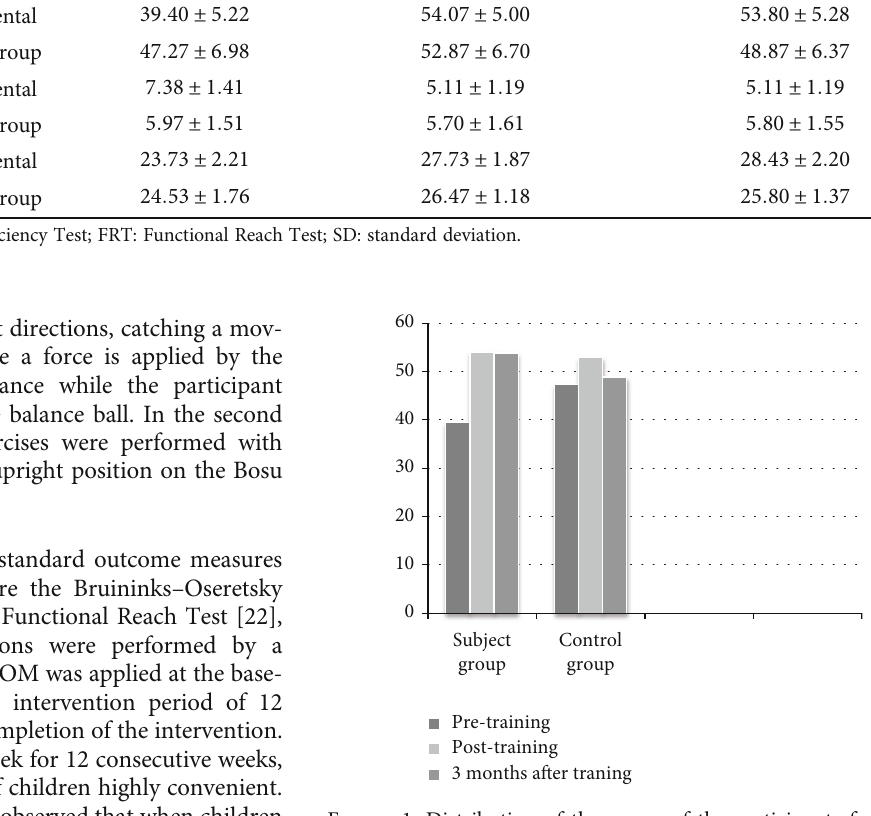
Figure 1: Distribution of the scores of the participants from the Bruininks – Oseretsky Motor Pro fi ciency